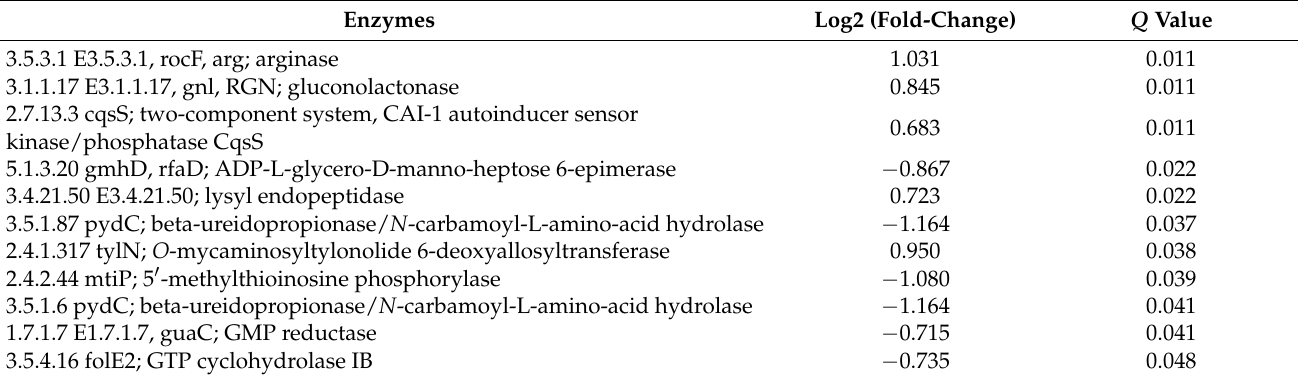
Table 8. Day 60 comparison of the enzyme levels of subjects demonstrating UV resistance following grape consumption on Days 30 and 60 ( n = 3) vs. subjects demonstrating resistance to UV irradiation following grape consumption only on Day 30 ( n =